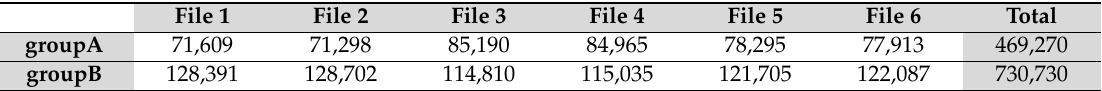
Table 2. Instances’ classes in every file in the SEA dataset.